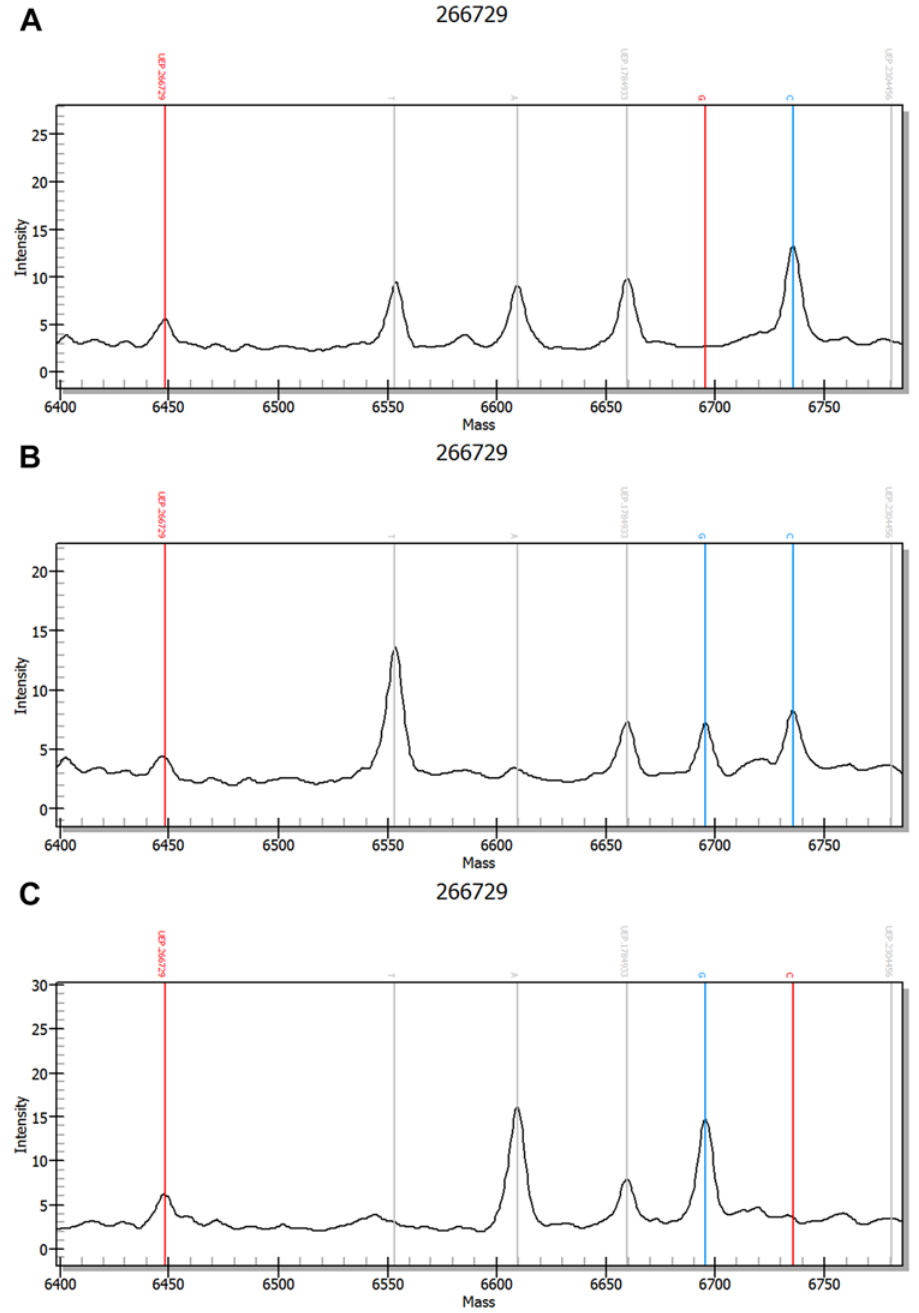
Fig 1. Spectrometric peak chart of rs266729. (A) ANP gene rs266729 (-11377C > G) CC genotype. (B) ANP gene rs266729 (-11377C > G) CG genotype. (C) ANP gene rs266729 (-11377C > G) GG